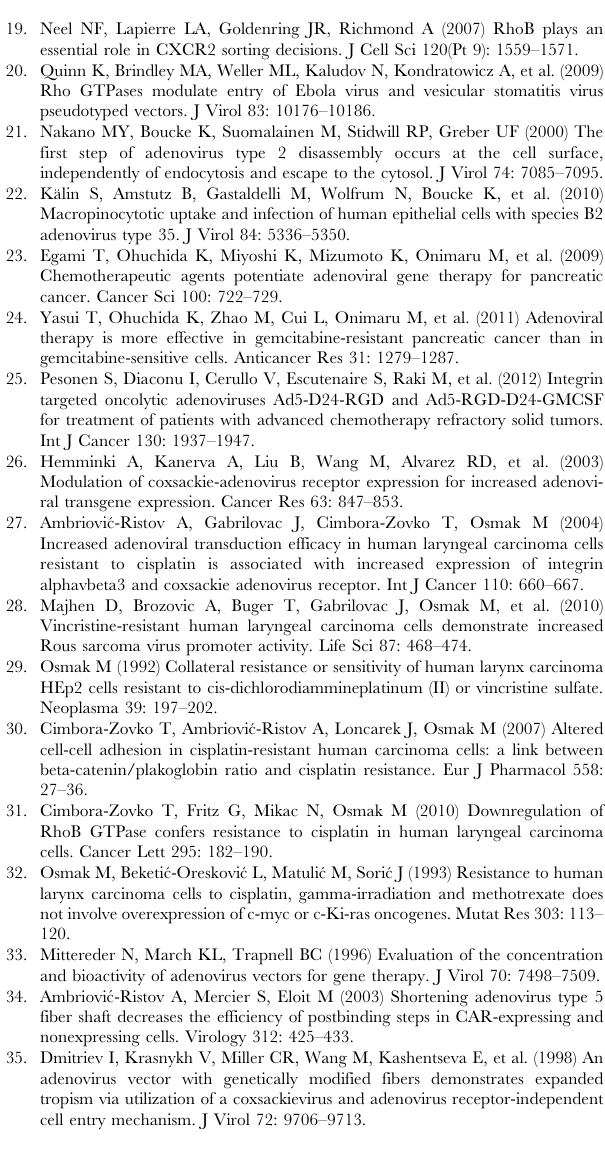
Figure S2 Cell surface levels of CAR, integrin heterodi- mers a 3 b 1, integrin subunits a 5 and b 1 on HEp2 and CK2 cells after transfection with control or